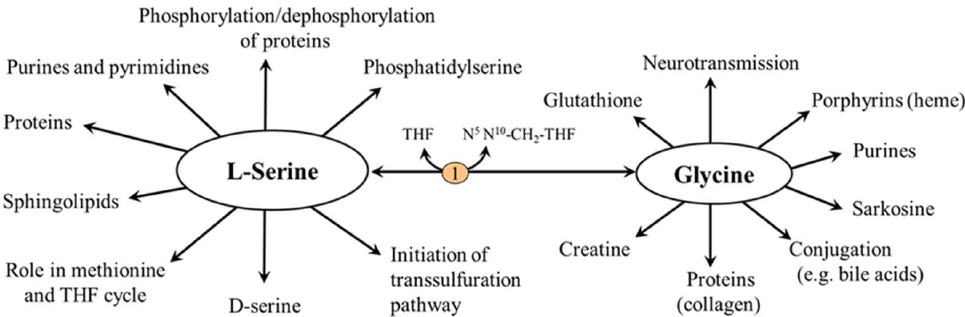
Figure 5. Main functions of L-serine. 1, serine hydroxymethyltransferase.